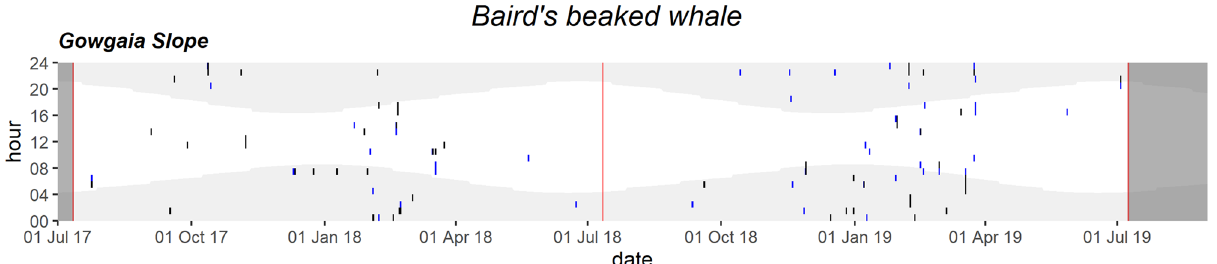
Figure 9. Daily and hourly occurrence of Baird’s beaked whale vocalizations at Gowgaia Slope in 1-h bins. Blue dots indicate automated detections. Black dots indicate confirmed occurrence. Red lines indicate recorder deployment and retrieval dates. Dark grey areas indicate a lack of recordings. Light grey shaded areas indicate hours of darkness.